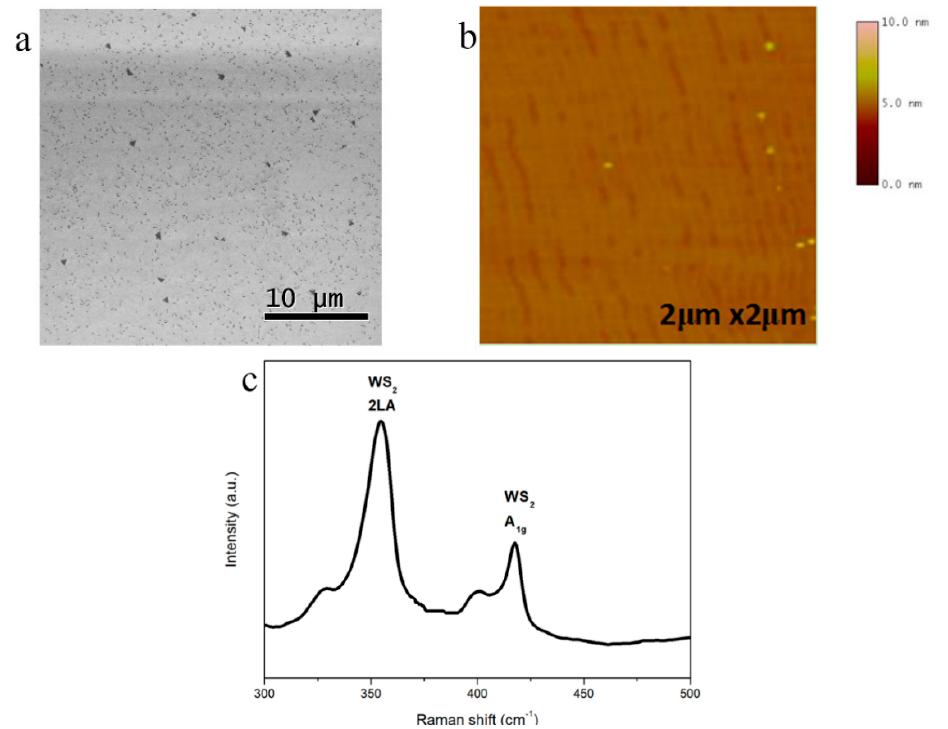
Figure 1. Characterizations of direct growth of WS 2 on sapphire substrate. ( a ) Scanning electron microscopy (SEM) image of the WS 2 film directly grown on sapphire substrates. ( b ) Atomic force microscopy (AFM) image of the WS 2 film with root mean square (RMS) roughness around 0.203 nm. ( c ) Raman spectra of the WS 2 film on sapphire